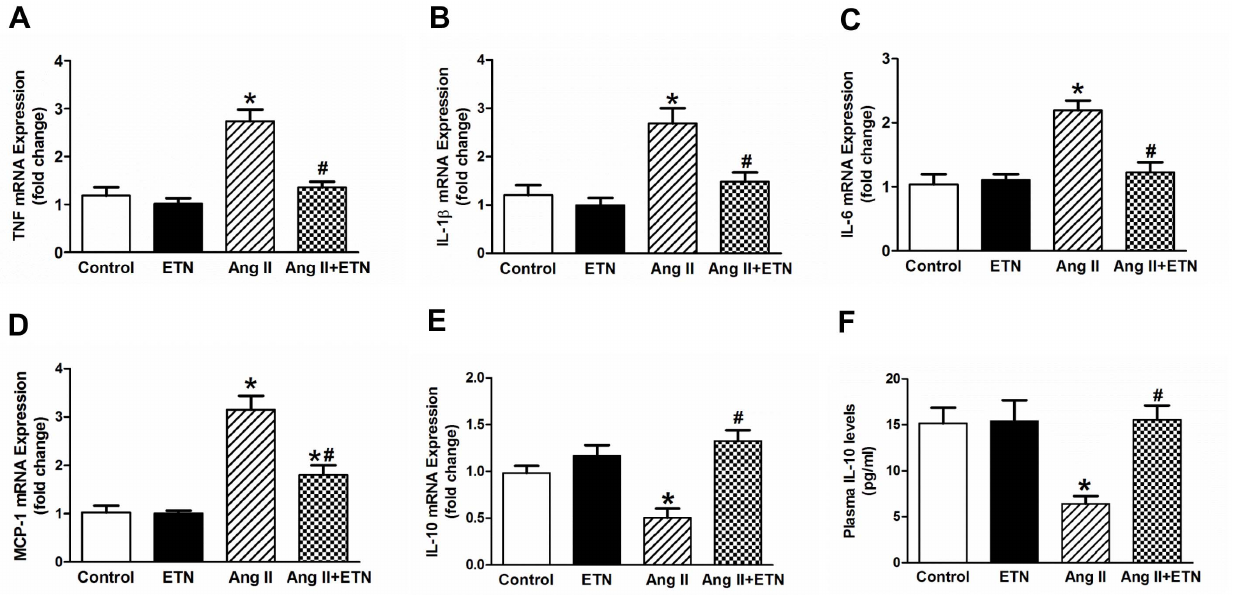
Figure 2. Effect of central TNF blockade on pro-and anti-inflammatory cytokine expression. Chronic Ang II infusion significantly increased the expression of TNF ( A ), IL-6 ( B ), IL-1 b ( C ), and the chemokine MCP-1 ( D ) in the PVN. This increase in PIC expression was attenuated in rats treated with etanercept. Furthermore, Ang II infusion significantly decreased the mRNA expression of the anti-inflammatory cytokine IL-10 in the PVN ( E ) and plasma ( F ) compared with controls. This decrease was restored by central TNF blockade with etanercept. n=8–10 per group, * p , 0.05 vs Control, # p , 0.05 vs Ang II.